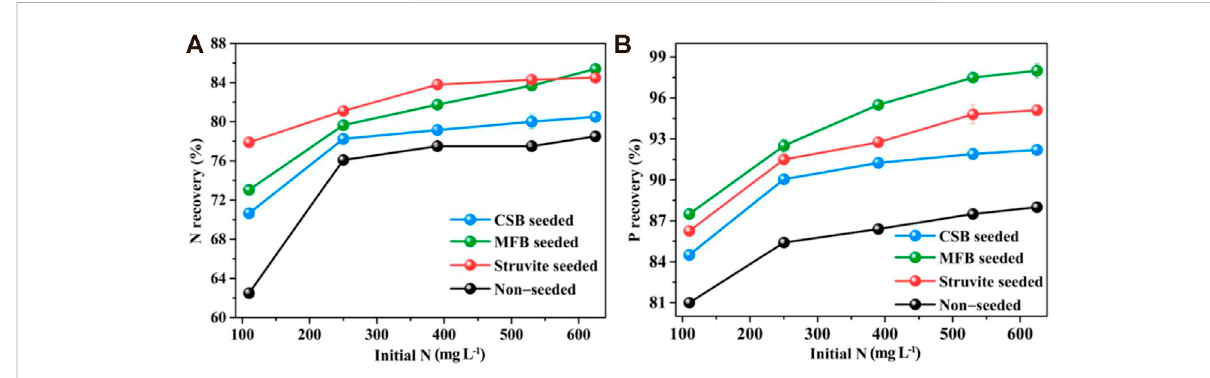
FIGURE 5 Effect of variation in initial N − NH 4 + concentration on nutrients recovery through struvite precipitation with various seeding materials from rural RTS refuse leachate (A) N recovery, (B) P